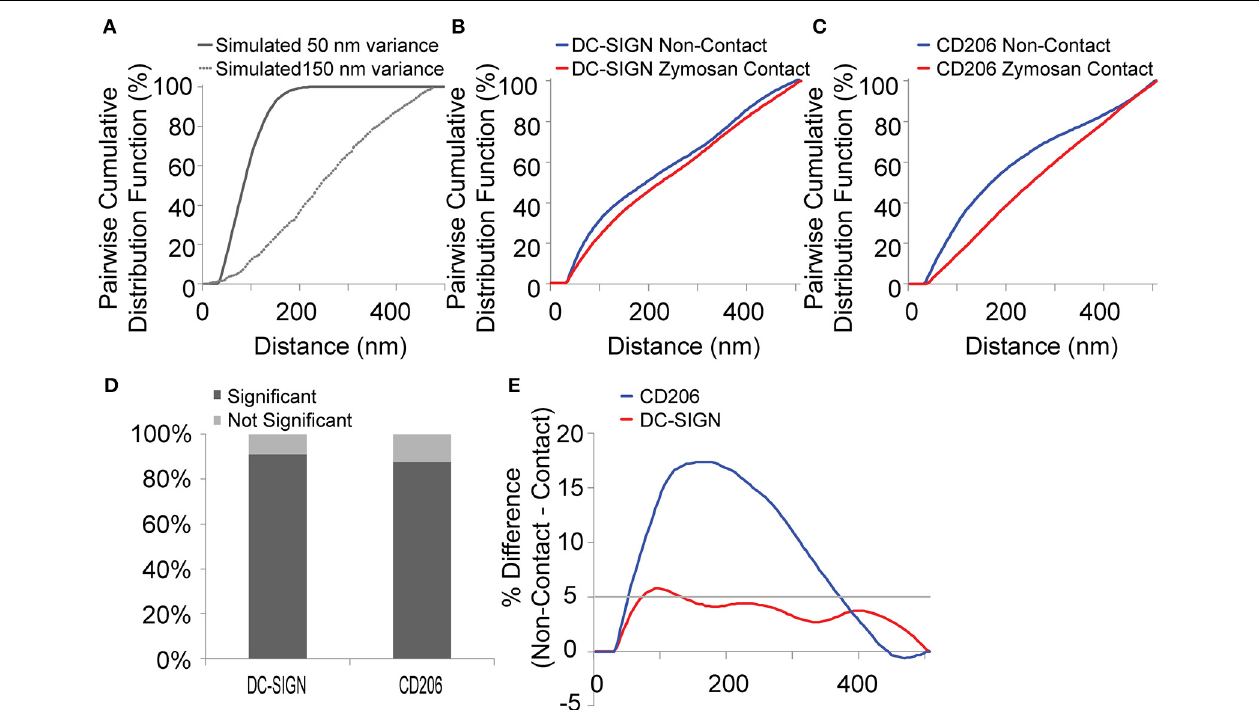
FIGURE 3 | Pairwise cumulative distribution function (CDF) analysis of super-resolution data. (A) CDFs of simulated data with a 50nm variance (dark gray) and 150nm variance (light gray). Note that the CDF curve shifts to the right when clustering occurs at a longer length scale. (B) CDFs of DC-SIGN in zymosan contact regions (red) and non-contact regions (blue) on dendritic cells. Data represents the average values for 11 pairs of data. (C) CD206 in zymosan contact regions (red) and non-contact regions (blue) on dendritic cells. Data represents the average values for 8 pairs of data. (D)